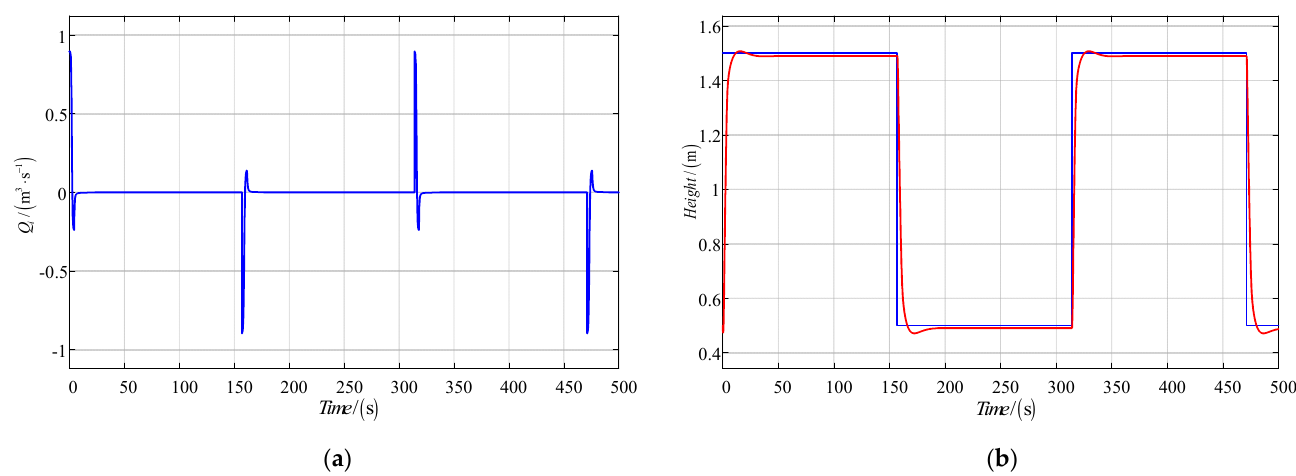
Figure 10. Simulation results of feedback fuzzy control: ( a ) represents the control input curve ( b ) represents the water level curve.